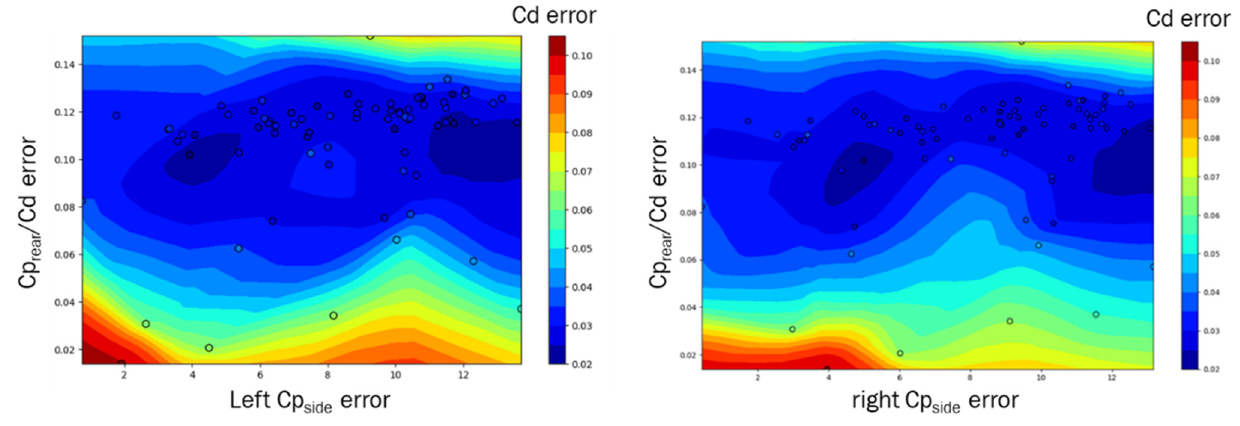
Figure 12. Cd objective versus rear pressure ratio and side pressure values for the driver side on left and passage side on right.